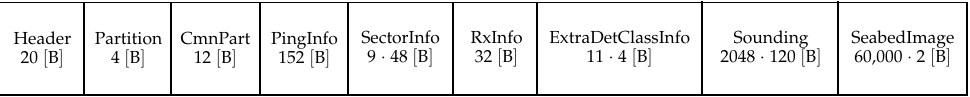
Figure 4. MRZ datagram as described by Kongsberg (410224 Revision H). Sizes of data elements not to